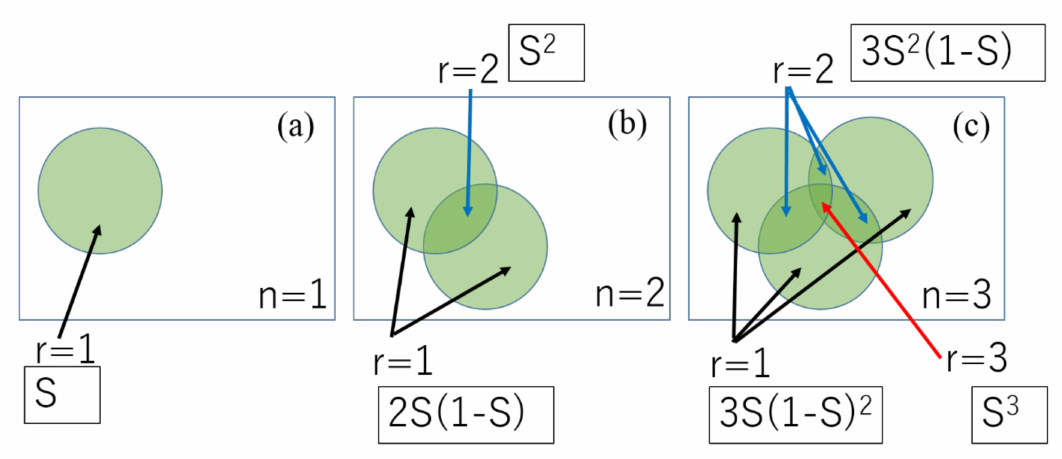
Figure 6. Schematic drawing of ion-track overlapping. Number of ion tracks is n , and the number of ion-track impacts is r . ( a ) production of single ion-track, ( b ) overlapping of ion-tracks by the production of second ion-track, and ( c ) overlapping of ion-tracks by the production of third